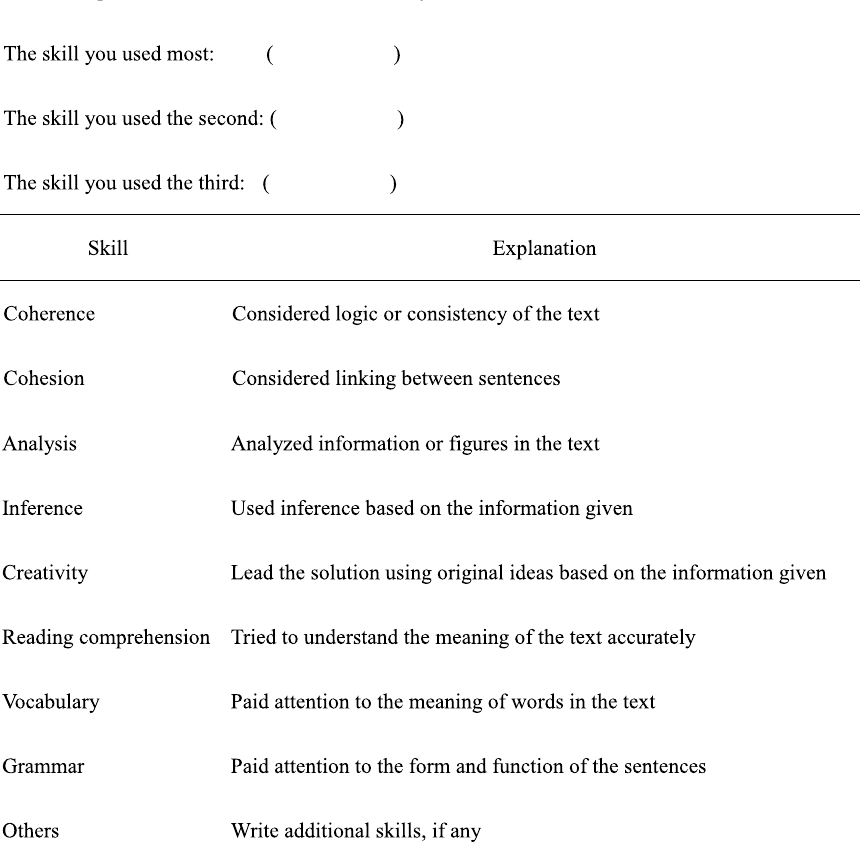
Table 2 A questionnaire inserted after every ECTT